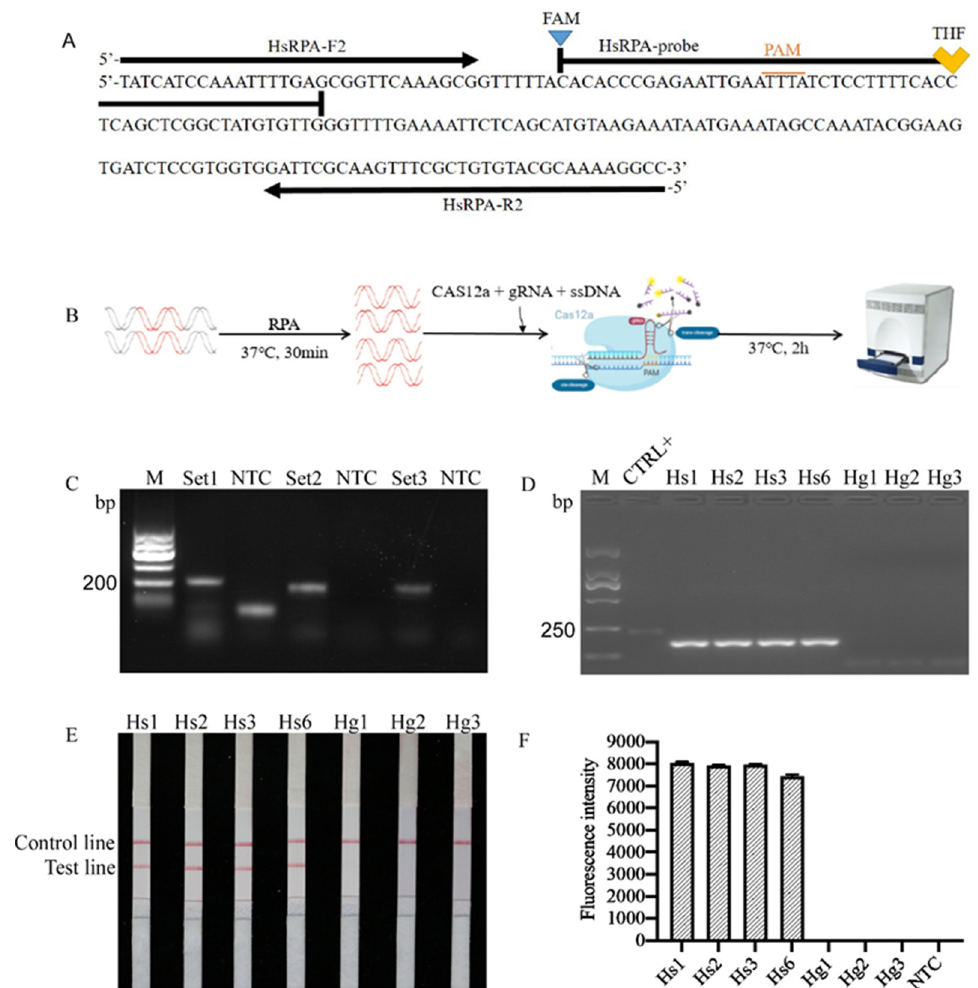
Figure 1. Screening of RPA primers for H. schachtii . ( A ) Partial nucleotide sequence of H. schachtii , showing the designed primers and probes. The position and amplification direction of the primers and probes are marked with black arrows. ( B ) Cas12a-mediated method of detection of DNA samples containing H. schachtii sequence. ( C ) Amplification bands generated using three pairs of RPA primers. ( D ) Specific amplification with selected primers was detected by agarose gel electrophoresis. ( E ) Specific amplification with selected primers detected using LFD test strips. ( F ) Specific amplification with selected primers detected using the RPA/Cas12a method. PAM, protospacer adjacent motif site (TTTA) for Cas12a recognition; CTRL+, the positive RPA control provided by the kit; M, D2000 marker; NTC, no template was added as a negative control. The presence of two lines indicates a positive result.